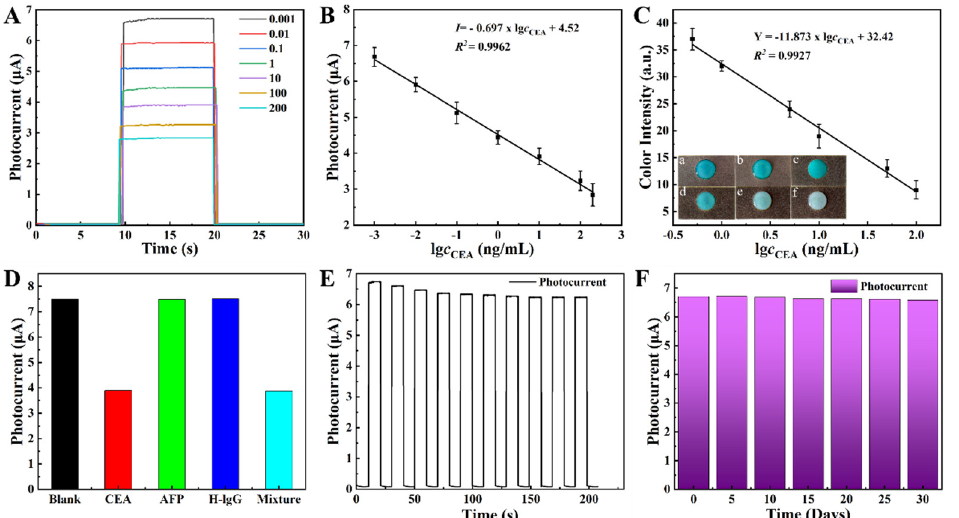
Figure 5. ( A ) Photocurrent signals of different concentrations of CEA from 0.001 to 200 ng·mL − 1 . ( B ) The calibration curve of ( A ). ( C ) Calibration curve and practical images (inset) of colorimetric detection mode with different concentrations from 0.1, 1, 5, 10, 50, to 100 ng·mL − 1 . ( D ) Selectivity of the proposed biosensing platform for the interferences (10 ng·mL − 1 ): the blank, CEA, AFP, H-lgG and Mixture. ( E ) Stability of the proposed lab-on-paper device at 0.001 ng·mL − 1 for 200 s. ( D ) The photocurrent response of PEC biosensor incubated with 0.001 ng·mL − 1 .